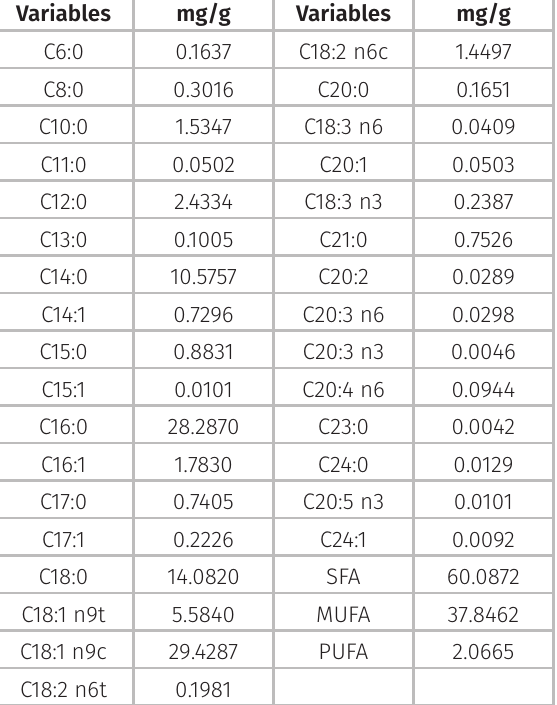
Table II. Profile of fatty acids from milk used in ripened cheese